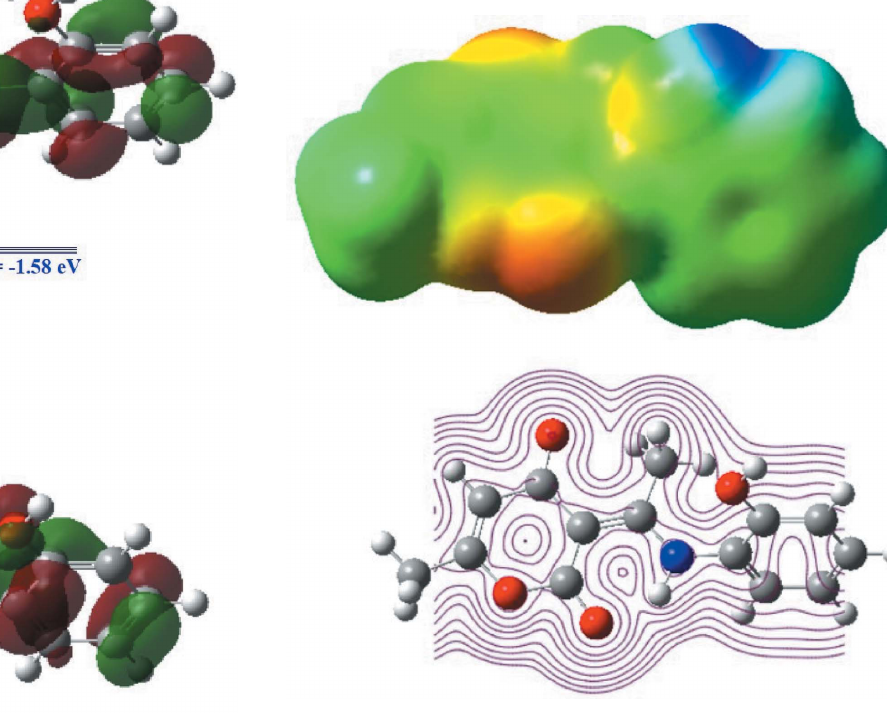
Figure 8 The energy band gap of the title